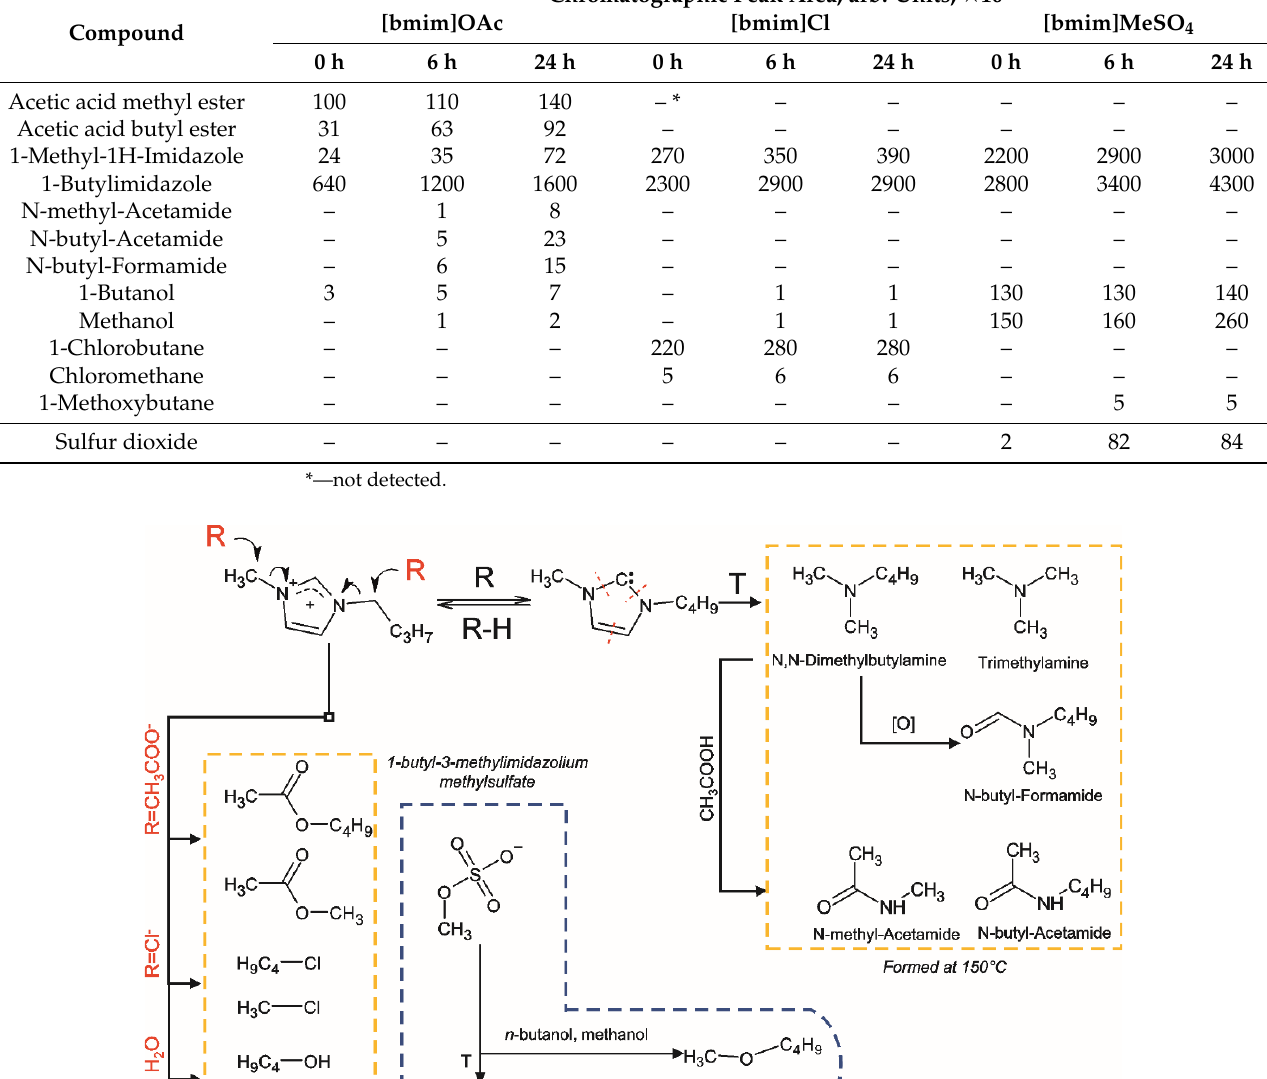
Table 2. Products of bmim acetate, chloride, and methyl sulfate pyrolysis at 242, 290, and 363 °C, respectively, identified by Py-GC-MS before (0-h) and after 6- and 24-h thermal treatment at 150 °C.